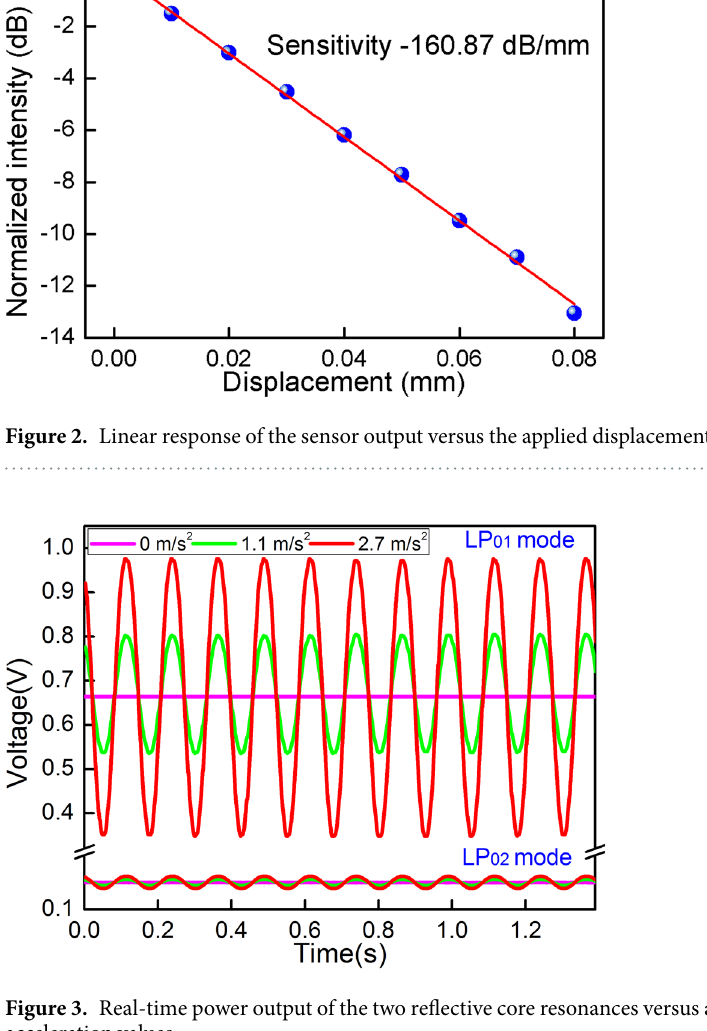
Figure 3. Real-time power output of the two reflective core resonances versus applied vibration with three acceleration